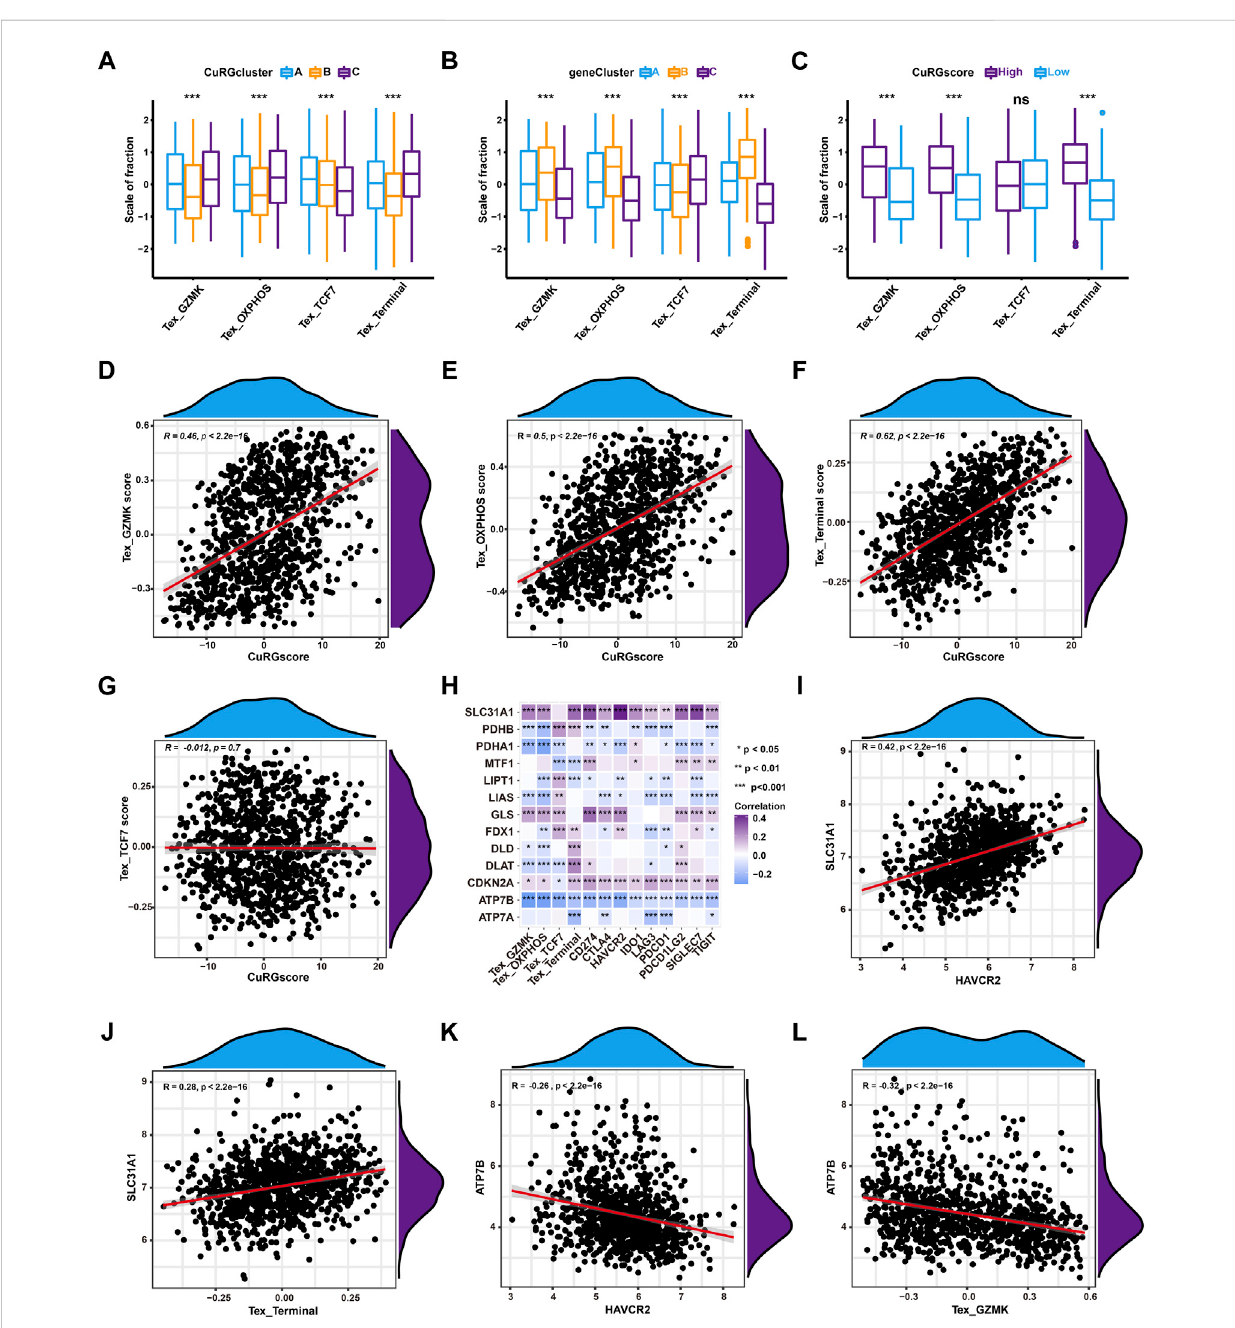
FIGURE 5 Correlation analyses between CuRGscore and TEX in the training cohort. (A, B) Differences in the four TEX phenotype scores among CuRGclusters A-C (A) or geneClusters A-C (B) . (C) Differences in the four TEX phenotype scores between high- and low-CuRGscores. (D – G) Spearman correlation analysis between CuRGscores and GZMK+ TEX (D) , OXPHOS- TEX (E) , Terminal TEX (F) , or TCF7+ TEX (G) scores. (H) Spearman correlation analyses between CuRGs and TEX markers, including TEX scores of the four subtypes and nine checkpoint genes. (I) Spearman correlation analysis between HAVCR2 and SLC31A1 . (J) Spearman correlation analysis between SLC31A1 and terminal TEX score. (K) Spearman correlation analysis between HAVCR2 and ATP7B . (L) Spearman correlation analysis between ATP7B and GZMK+ TEX